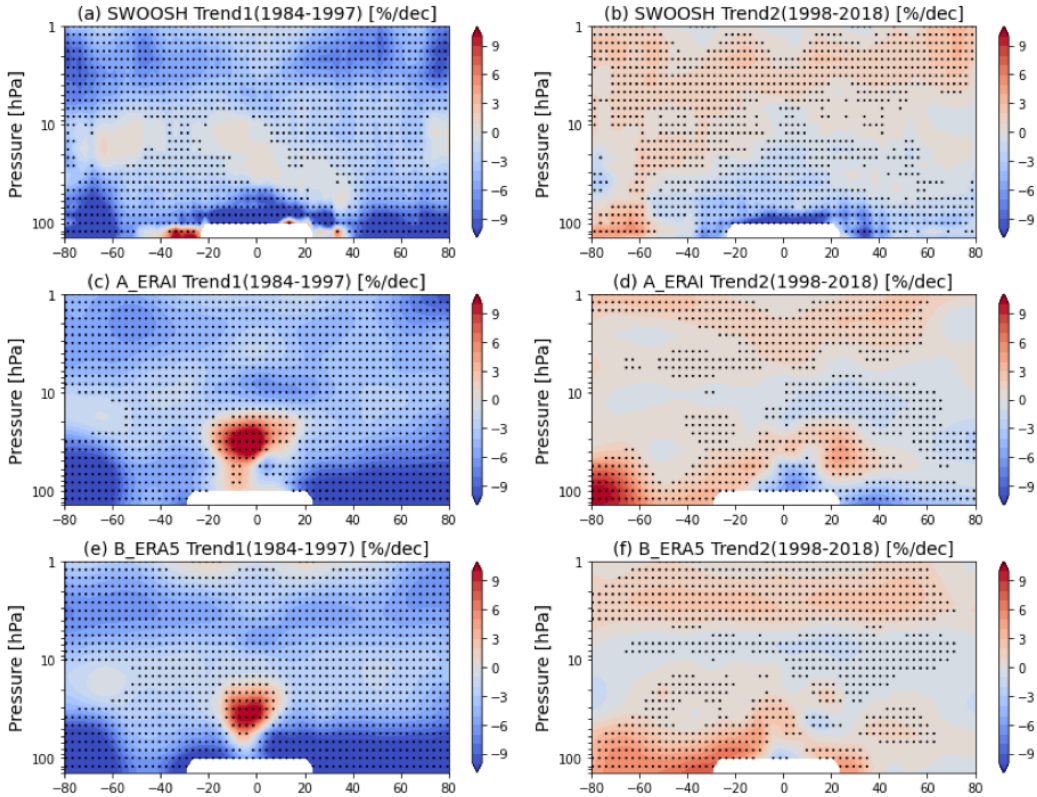
Figure 9. Latitude–pressure cross sections of the piecewise linear trends of ozone anomalies (% per decade) over the periods 1984–1997 and 1998–2018 for (a, b) SWOOSH, (c, d) A_ERAI, and (e, f) B_ERA5, respectively. Stippled regions indicate where the trends are statistically significant at 95% level of